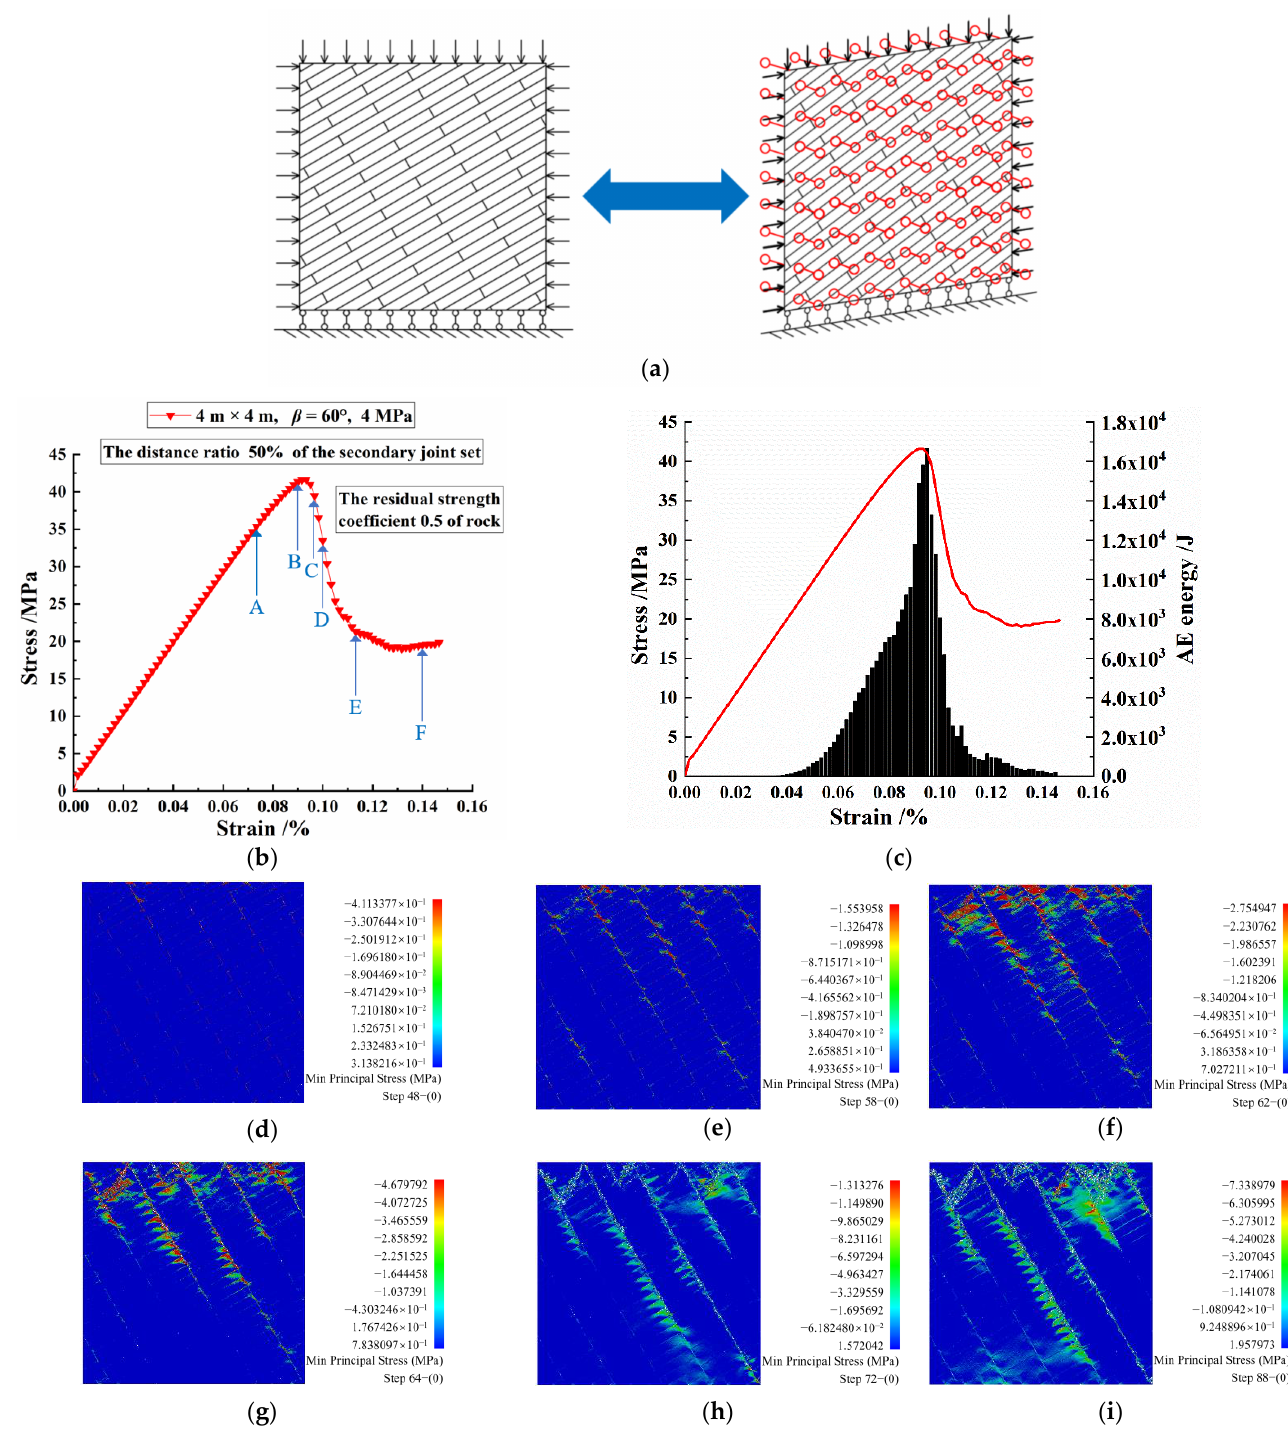
Figure 14. ( a ) Under plane strain, the schematic diagram of the CJBs model with β = 60° and the joint distance ratio 50%; ( b , c ) the loading curve and AE energy; ( d – i ) the minor principal stress contours at the Points A~F.